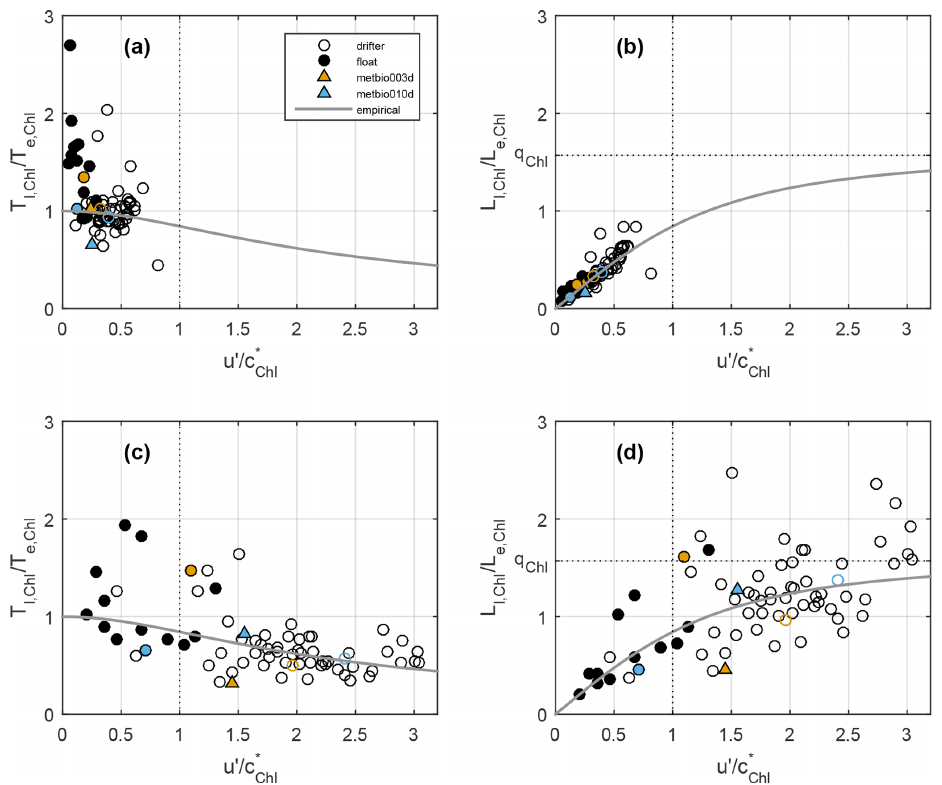
Figure D1. The same as Fig. 6 but with float scales calculated by integrating Eq. (9) (space-composited ACF) instead of integrating Eq. (8) (individual segment ACF) and averaging over